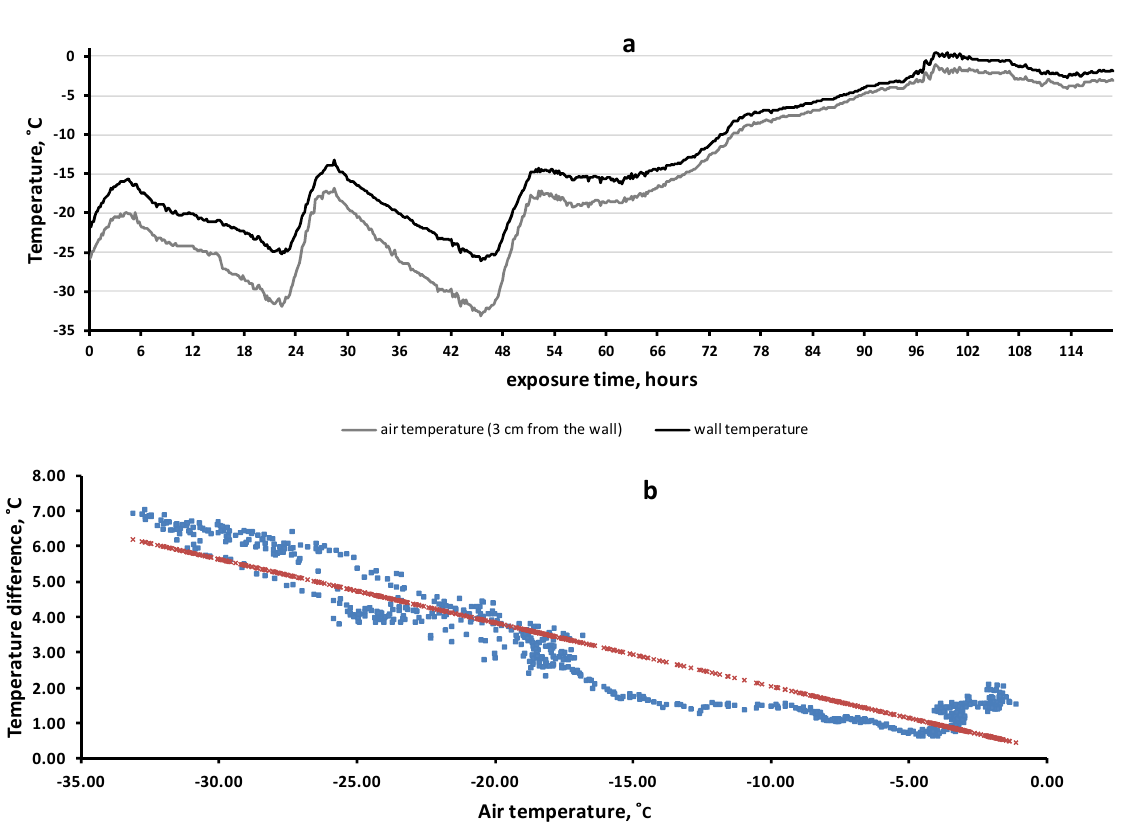
Figure 6. Temperature dynamics of the wall surface of the house and in the near-wall air layer (11–16 February 2021) ( a ). The regression of temperature difference (between the wall and the air) by air temperature ( b ).